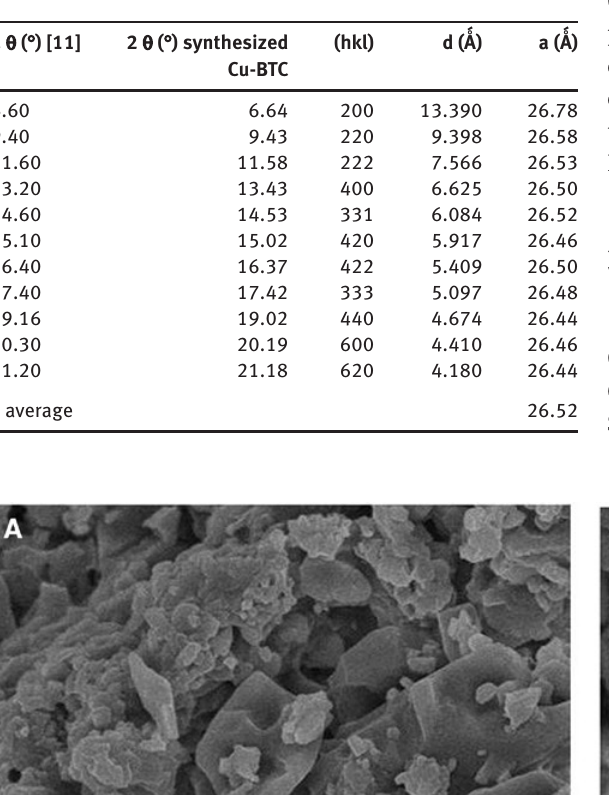
Table 3: 2 θ , (hkl), distance between crystal plane d and lattice parameter a of Cu-BTC, formed from Cu and benzene-1,3,5- tricarboxylic acid, synthesized with electrolyte tetrabutylammonium tetrafluoroborate